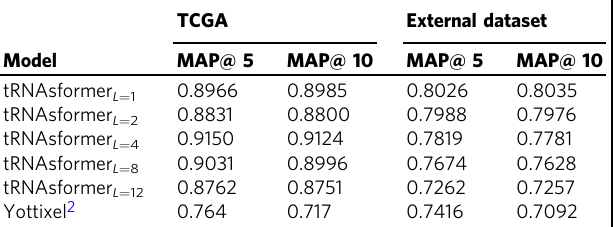
Table 4 The MAP@5 and MAP@10 values for all WSI search models applied on the TCGA test and the external